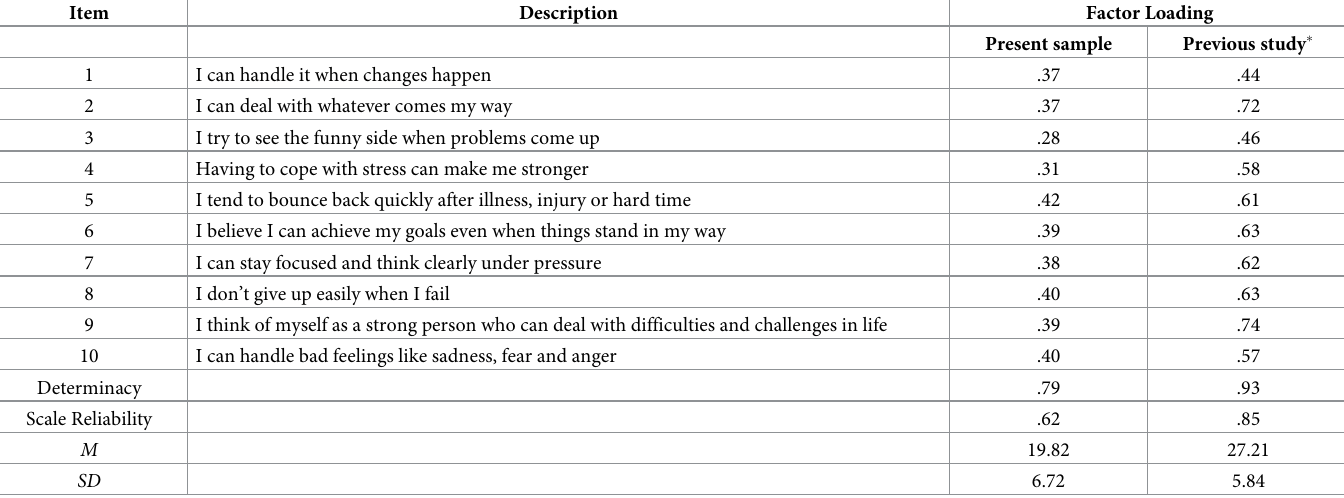
Table 2. Confirmatory factor analysis of the 10-item Connor-Davidson Resilience Scale (CD-RISC-10): Psychometric comparisons with Campbell-Sills & Stein, (2007)